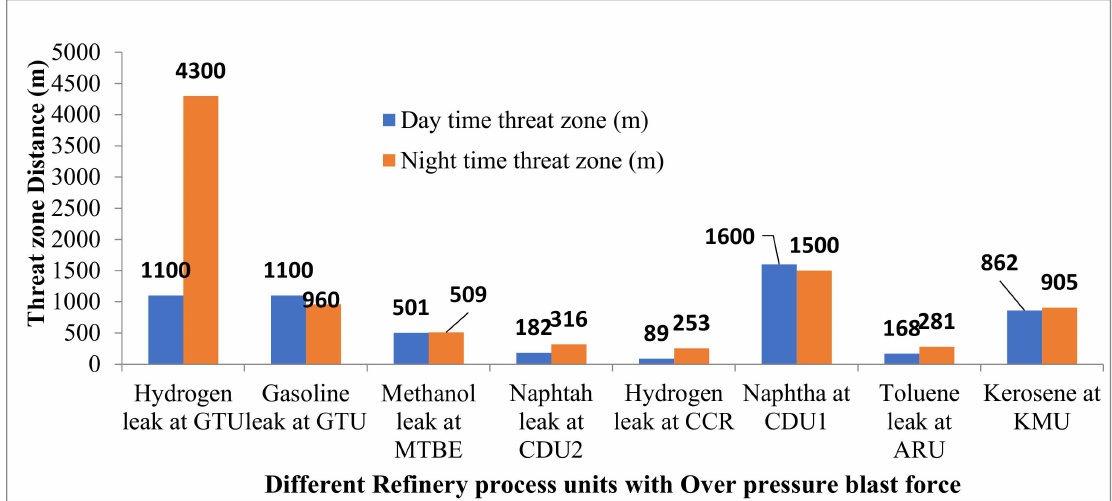
Figure 7. Threat zones for blast force from vapor cloud